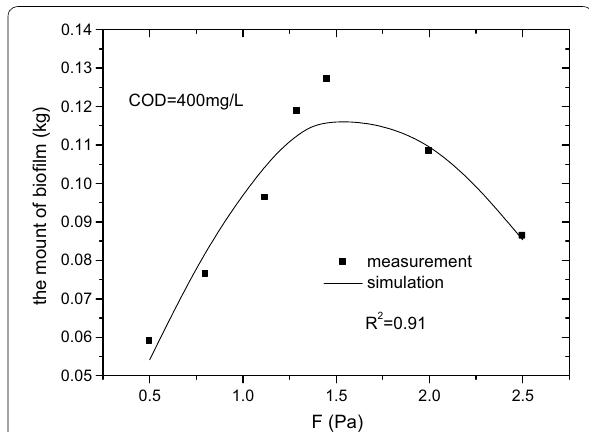
Fig. 7 Microorganism amount vs wall-shear stress, COD 400 mg/L. = The amount of microorganism increased with the increase of wall-shear stress until the wall-shear stress reached 1.45 Pa. When wall-shear stress exceeded 1.45 Pa, although the biofilm density increased as well, the thickness of biofilm decreased at a greater degree, resulting the drop of the microorganism amount. When the wall-shear stress was 1.45 Pa, the average biofilm density was 74 5 kg/m 3 , just 7.5% less than which obtained at wall-shear stress ± Fig. 8 Microorganism amount vs wall-shear stress, COD of 2.0 Pa, while the biofilm thickness was 2.4 0.1 mm, 20.8% greater ± In addition, in order to validate the model, the measured data was than which reached at wall-shear stress of 2.0 Pa. The R 2 of Eq. (3) was used when COD was 200 mg/L. The R 2 was 0.91, indicating that it is reasonable